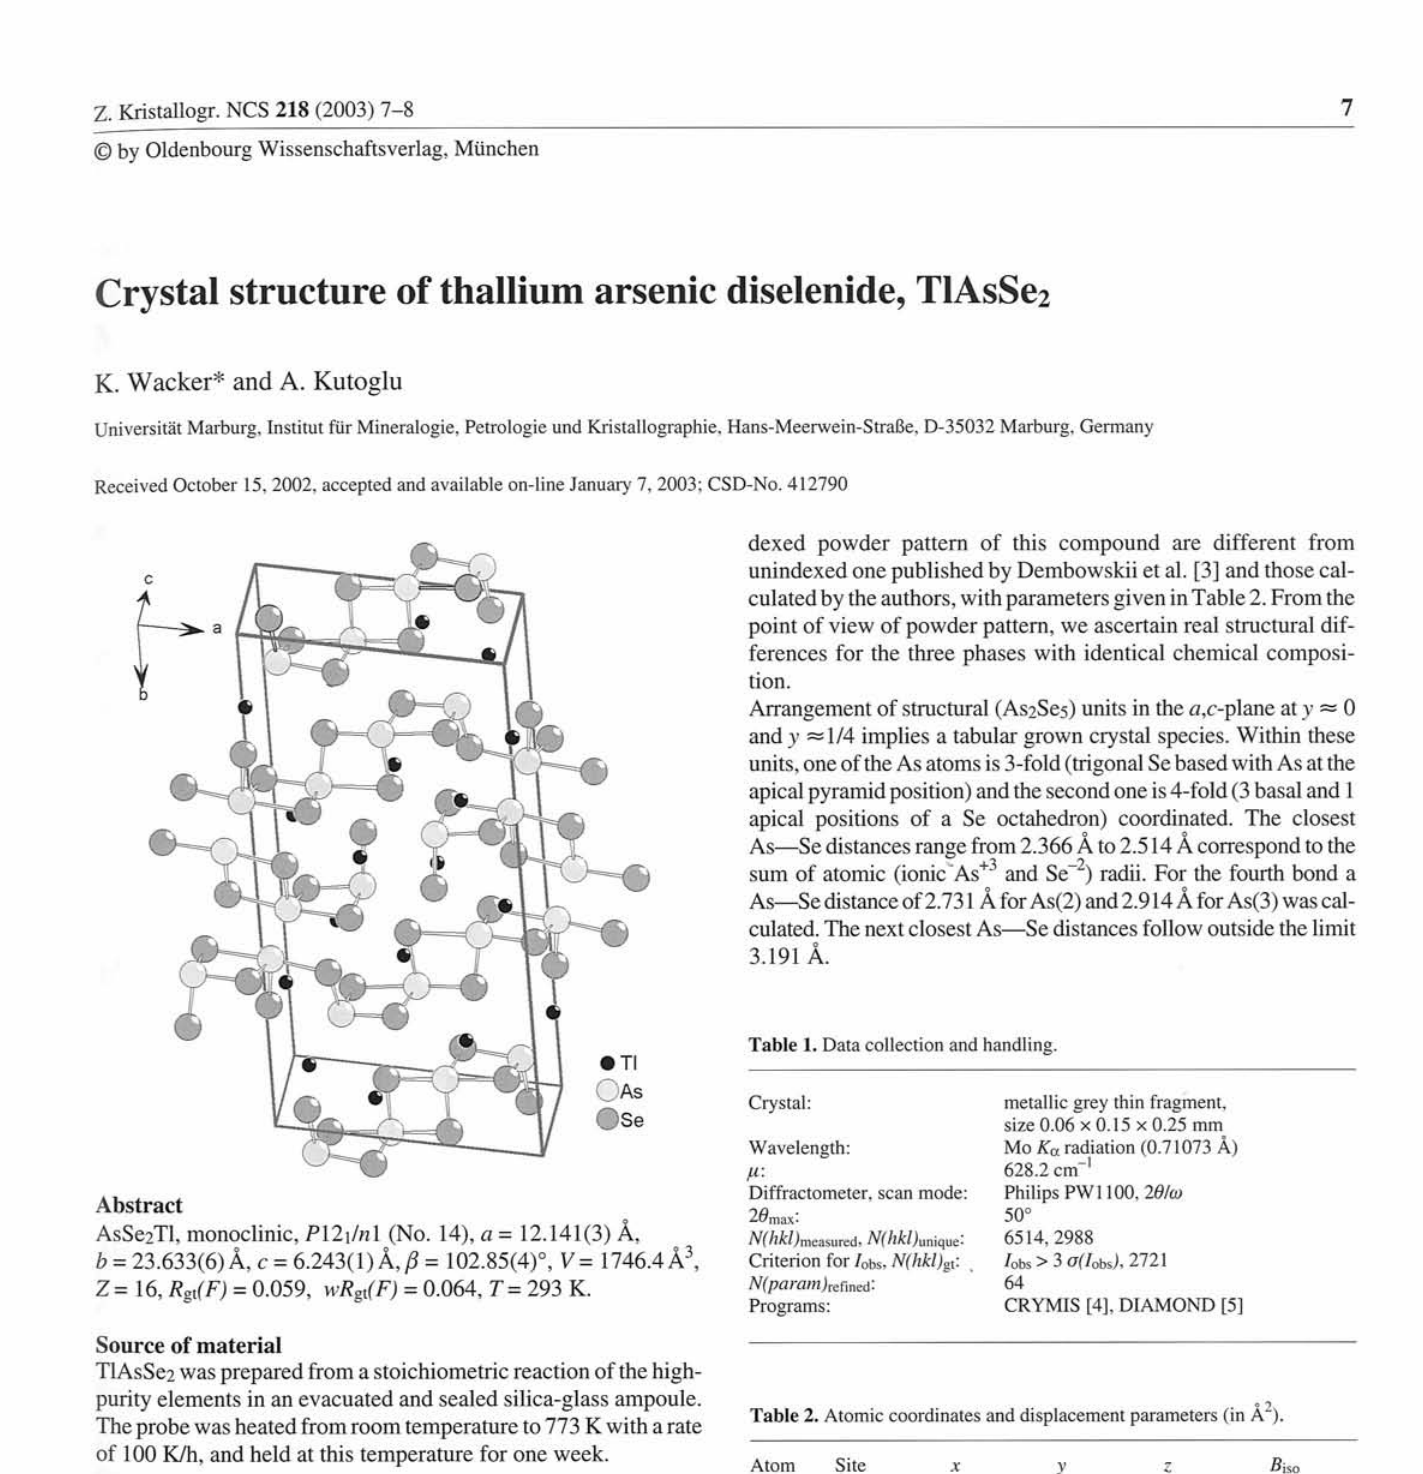
Table 2. Atomic coordinates and displacement parameters (in A